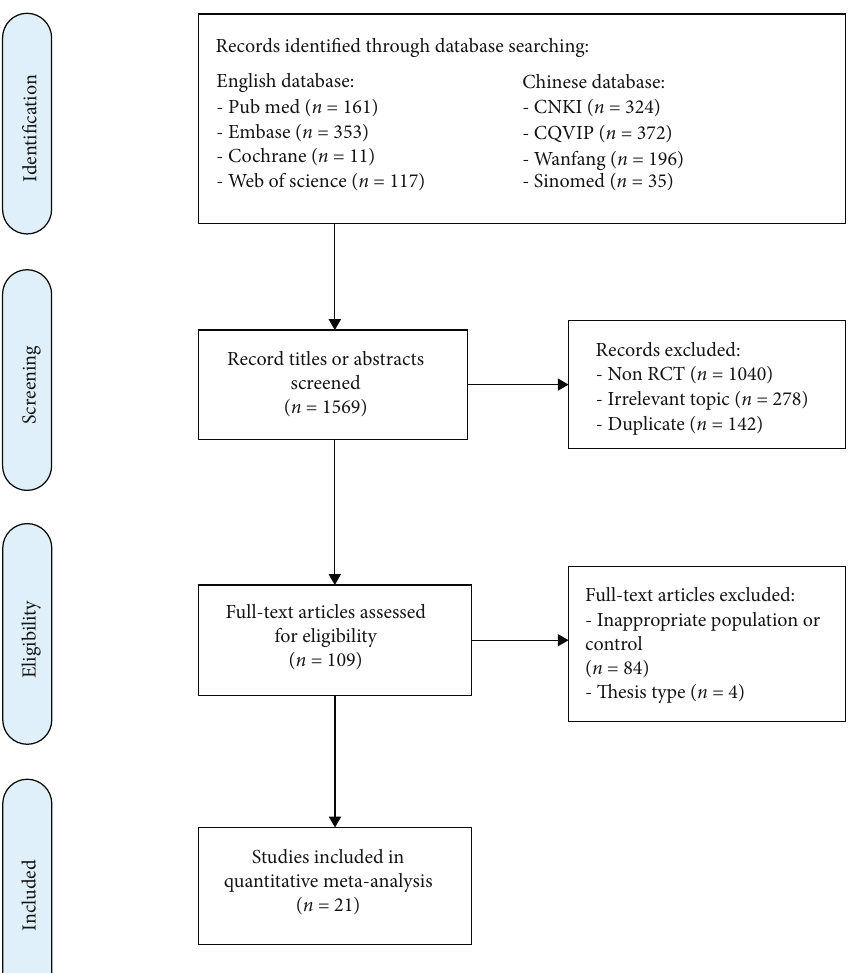
Figure 1: Flow diagram of the study search and selection